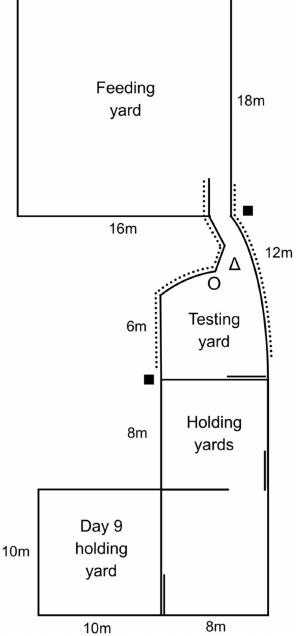
Figure 1. Diagram of the acclimation rate testing set up. The solid square symbols ‘ (cid:4) ’ denote the position of two cameras, the open triangle ‘ ∆ ’ denotes the position of a traffic cone in phase 2 of testing and the open circle ‘O’ denotes the position of a person in the final phases of testing. The dotted lines denote which panels in the yards were covered with opaque rubber matting. The figure is approximately to